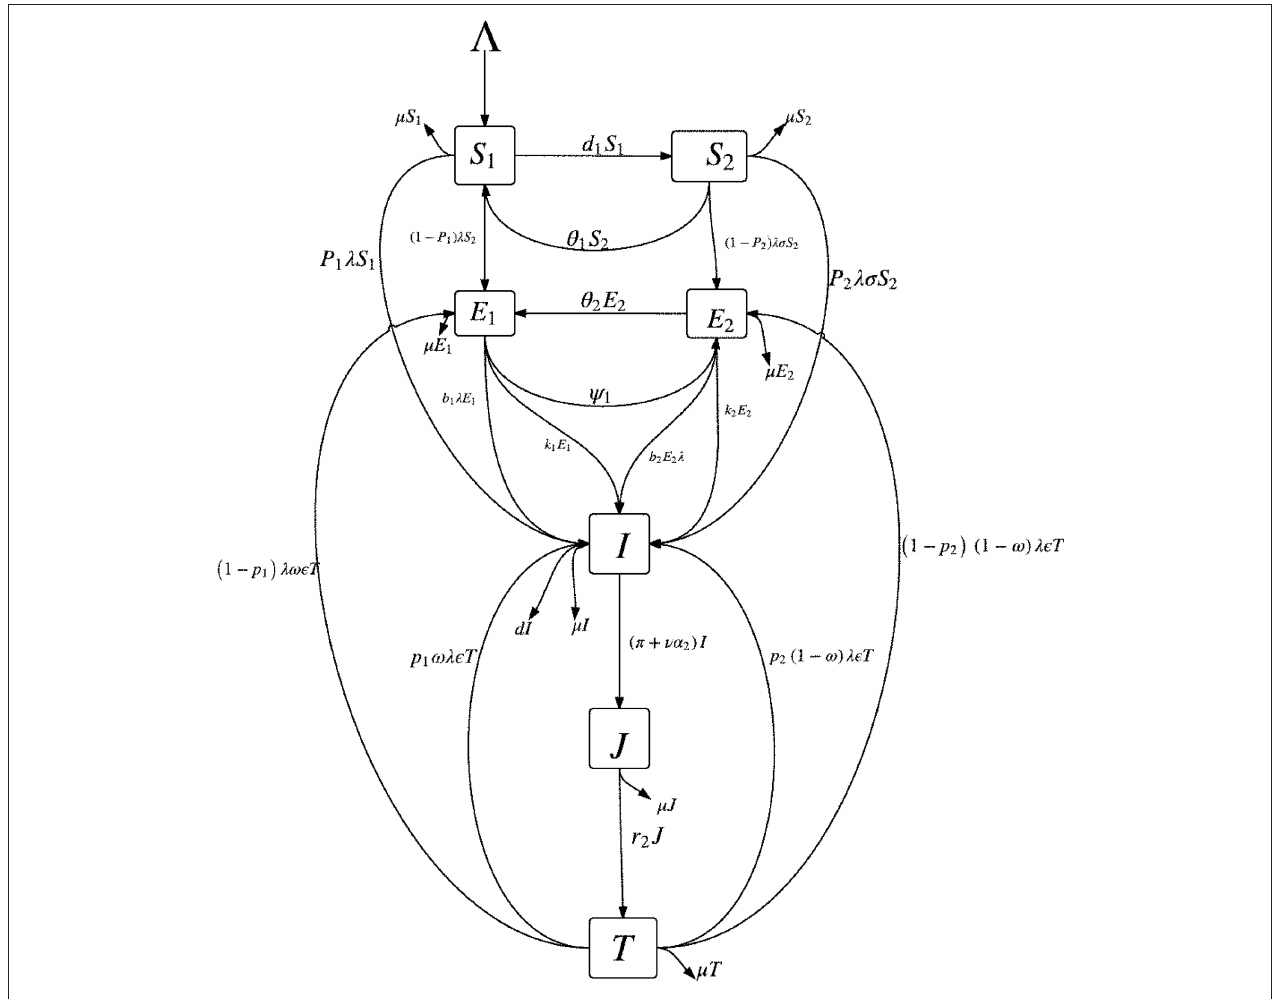
FIGURE 1 | Schematic diagram of model given in (3), where λ = β ( I + η J ) N .